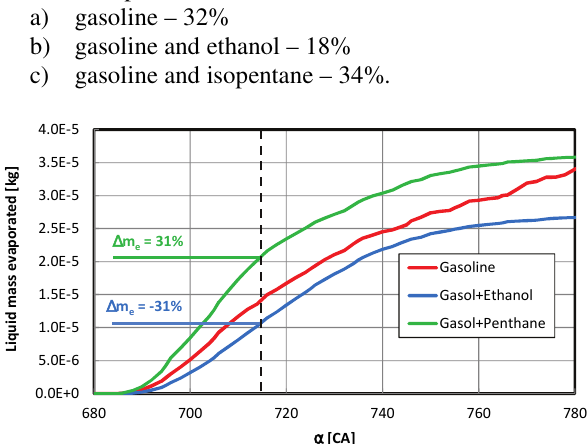
Fig. 14. The effect of the evaporated dose quantity in the combustion chamber on the fuel type during its injection and spray This implies that mixing fuels before ignition allows for reducing the fuel evaporation speed by 25% (gasoline and ethanol) or increasing this speed by 46% (gasoline and isopentane) versus the standard gasoline injection. This means that gasoline-isopentane mixture lets achieve almost double (92%) the evaporated mass than the gasoline- ethanol mixture.